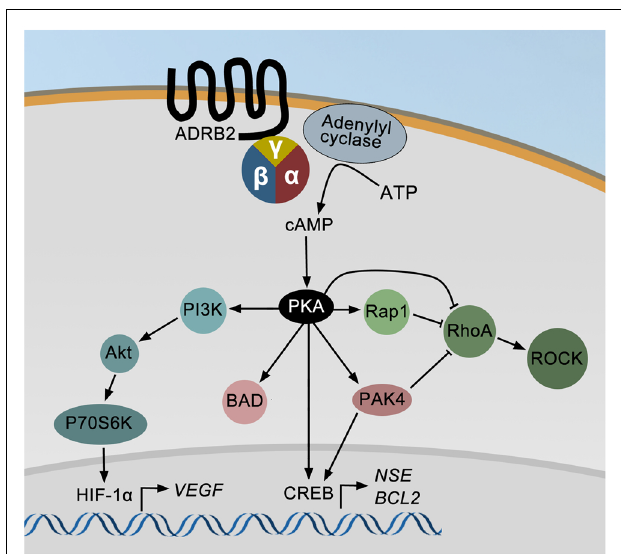
FIGURE 1 |TheADRB2 signaling pathways in prostate cancer . Ligand binding to ADRB2 increases the intracellular level of cAMP, which activates cAMP-dependent protein kinase (PKA). PKA may either directly or through PAK4 stimulate CREB activity and thereby induce the expression of ENO2 and BCL2 . PKA can also directly or indirectly via PAK4 or Rap1 inhibit RhoA and ROCK activities and thereby induce neurite outgrowth. Finally, VEGF expression is up-regulated by adrenergic stimulation via PI3K/AKT/p70S6K mediated activation of HIF-1 α